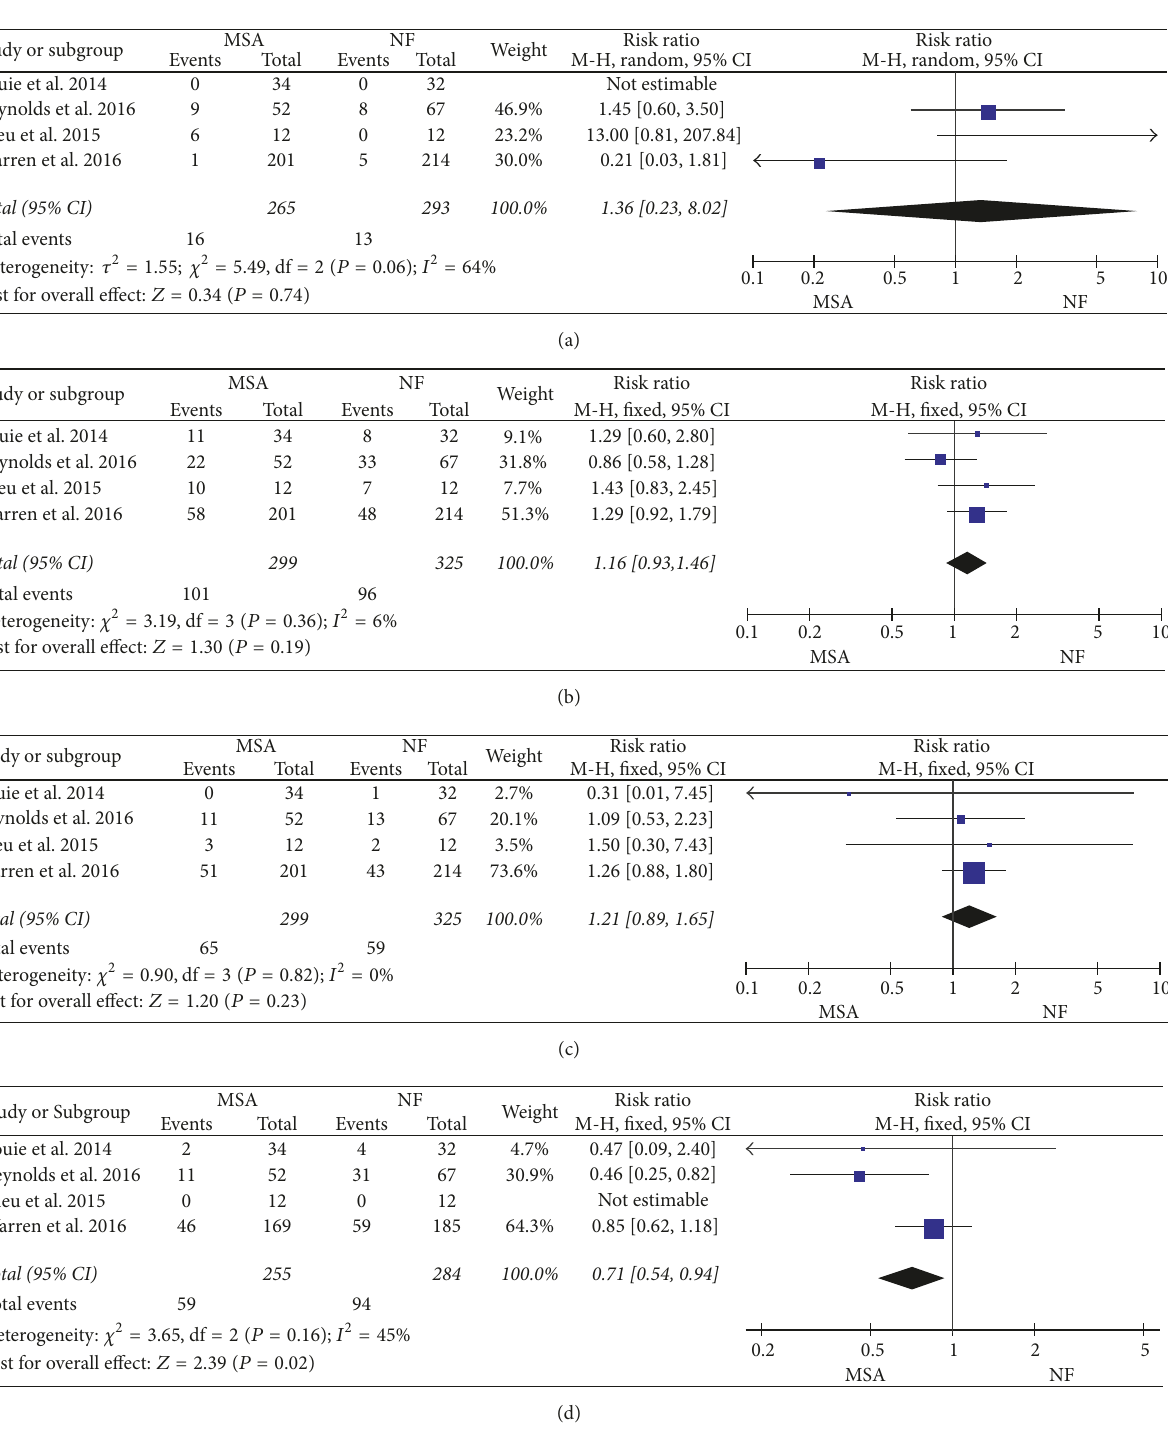
Figure 4: Forest plot of studies evaluating risk ratios of adverse events (a), ability to belch (b), ability to vomit (c), and gas-bloating